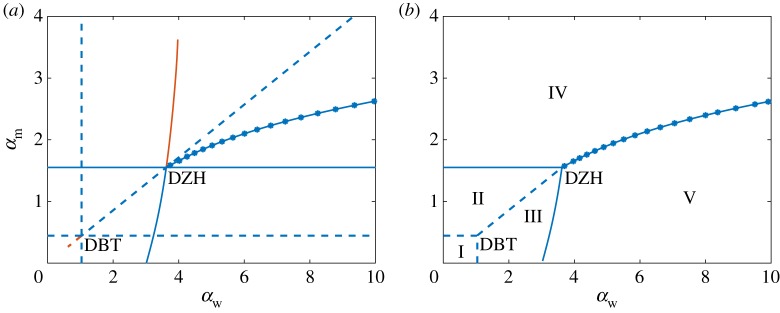
(a) Two-dimensional bifurcation diagram, illustrating the effect of infection rates on the dynamics of the system. Blue denotes biologically meaningful solutions (positive values for all components). Orange describes solutions with negative components, which are not biologically meaningful. The abbreviations DBT and DZH mark the locations of degenerate Bogdanov–Takens and degenerate zero-Hopf bifurcations, respectively. (b) Two-dimensional stability diagram with the biologically meaningless bifurcations removed, showing five regions of distinct dynamics. Solid, dashed and starred lines represent curves of Hopf bifurcations, transcritical bifurcations of fixed points and transcritical bifurcations of periodic orbits (POs). Region I: stability of virus-free solution; Region II: stability of wt-free state; Region III: stability of coexistence state; Region IV: stable PO around the wt-free state; Region V: stable PO around the coexistence state. In both plots, the parameter values are given by (3.12).